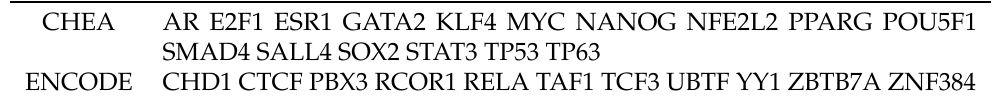
Table 5. Twenty seven commonly selected TFs from Figure 5.